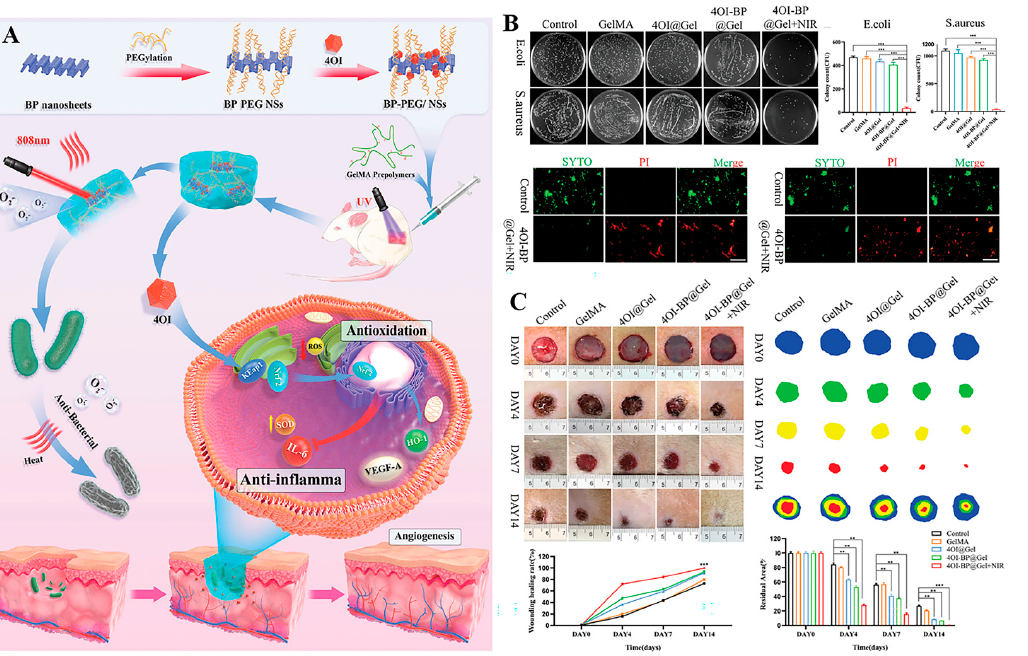
Figure 9. ( A ) Schematic illustration of the preparation procedure of the 4-octyl itaconate (4OI)-modified black phosphorus (BP) nanosheets loaded gelatin methacrylamide hydrogel to produce a new photothermal therapy (PTT) and photodynamic therapy (PDT) system under single NIR irradiation (808 nm) with antibacterial properties for diabetic wound healing. ( B ) In vitro antibacterial effects